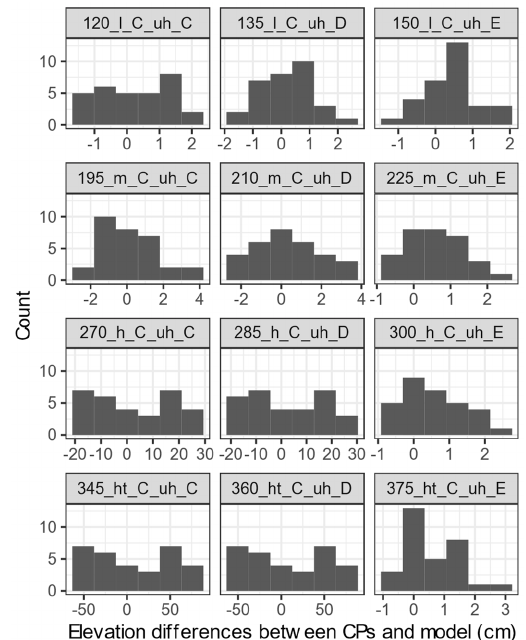
Figure 5. Distribution of the difference in elevation between 30 CPs and DEMs for the 12 selected workflows. The histograms are arranged according to the sets of optimization parameters and the level of accuracy of image alignment: in the first column there are four histograms for projects with the “C” set, in the second with the “D” set, and in the third with the “E” set. The level of accuracy for generating the sparse point cloud in the column is set from low (first row) to highest (fourth row). All histograms are for projects where the quality of dense point cloud generation has been set to ultra-high. The following regularities can be seen: (1) increasing the quality of generating a sparse point cloud increases the differences in elevation for models with optimized parameter sets “C” and “D” (approximately from − 2 to 2 cm for low, from − 2 to 4 cm for medium, from − 20 to 30 cm for high and from − 50 to 50 cm for ultra-high quality); (2) optimization of the sparse point cloud with all parameters (set “E”) significantly affects the accuracy of the models, resulting in the standard deviation of <2.5 cm. In addition to analyzing the quality of the models, the calculation time for each step was checked, while calculation time for each project was summarized to compare the workflows in terms of calculation time and test if the increase in accuracy can be achieved with reasonable computing time. The step of generating a dense point cloud turned out to be crucial—the calculation time at the lowest level of accuracy may be shorter than ultra-high even six times, and between high and ultra-high three times (Table 1). The detailed results of the calculations, along with the quantitative and qualitative characteristics of the models, can be found in the Supplementary Materials (S1).